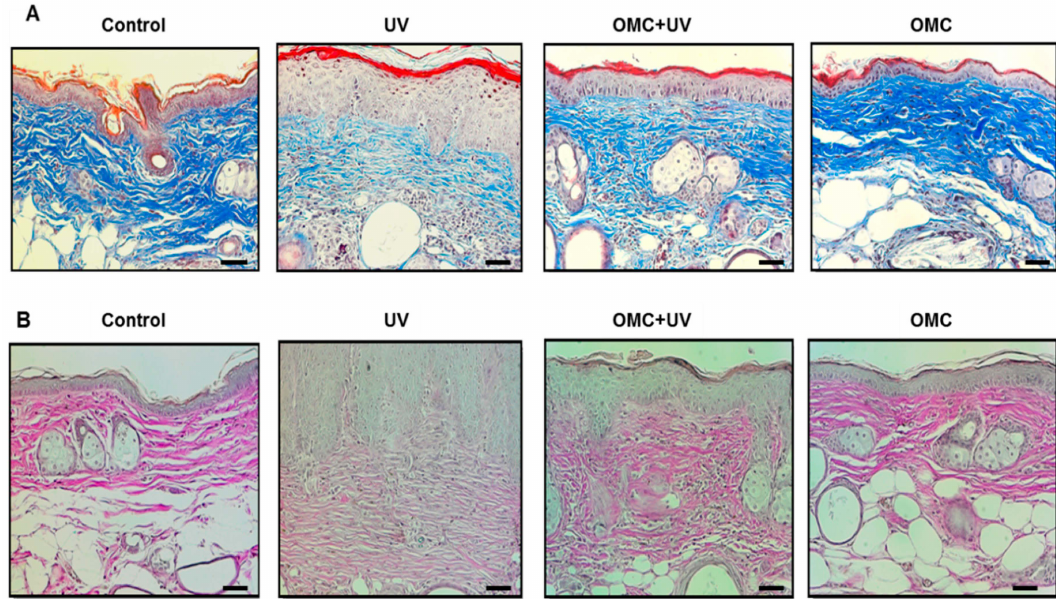
Figure 3. Effects of Octylmethoxycinnamate (OMC) on collagen fibers and elastin expression in UV-irradiated SKH-1 hairless mice. ( A ) After a 15-week application of OMC, histological observation of collagen fibers in photoaged SKH-1 hairless mice skin with Masson’s Trichrome stain was performed; ( B ) After a 15-week application of OMC, histological observation of elastin in photoaged SKH-1 hairless mice skin was performed with Verhoeff’s stain. Representative figures show that OMC rescued the UV-increased decrease in collagen fibers and elastin expression. Scale bar = 20 µ